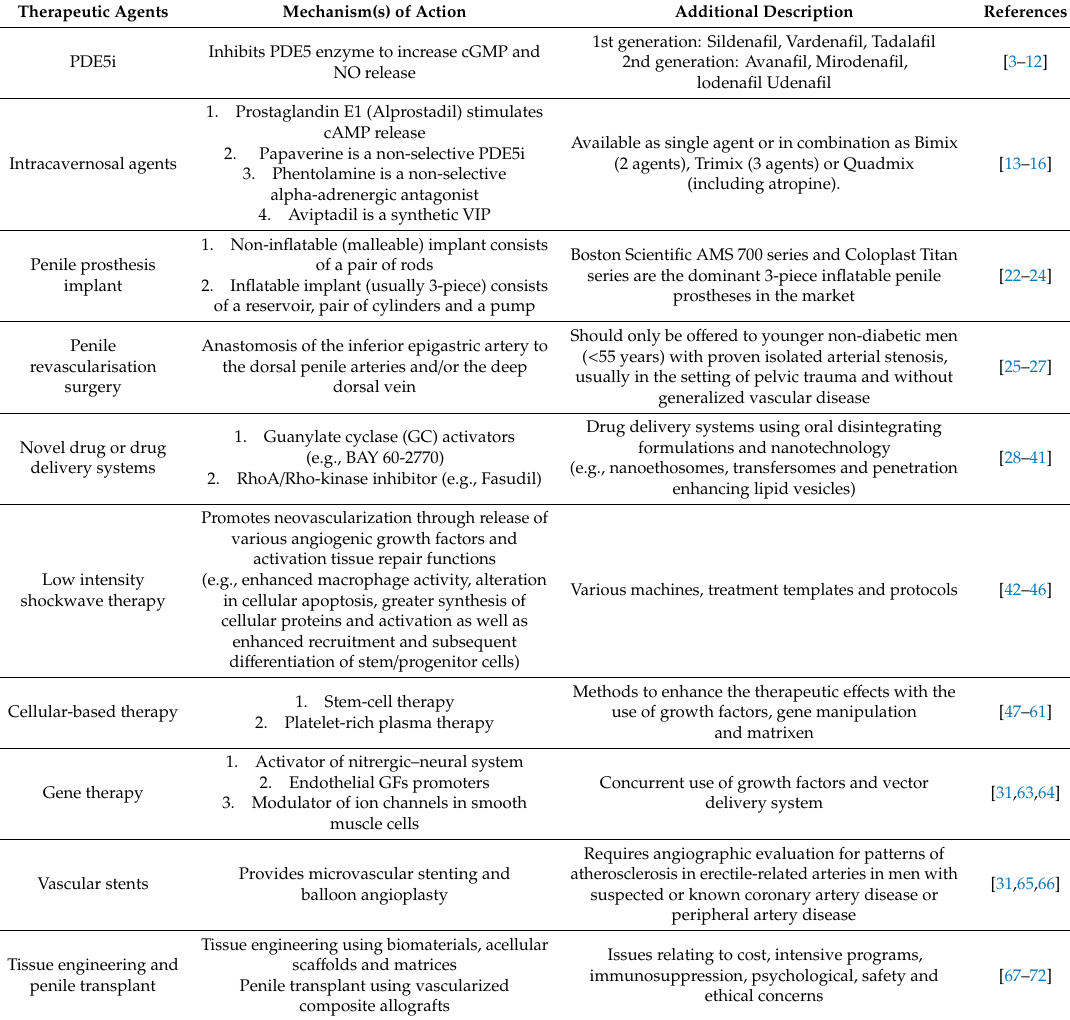
Table 1. Current and emerging therapeutic options for erectile